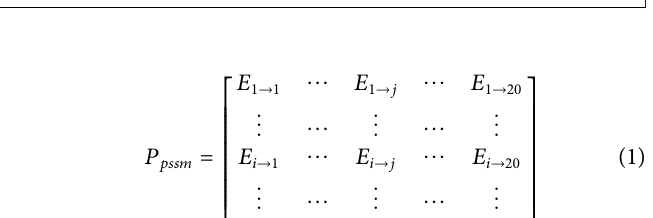
FIGURE 1 | Predicting subcellular localization of a given protein by